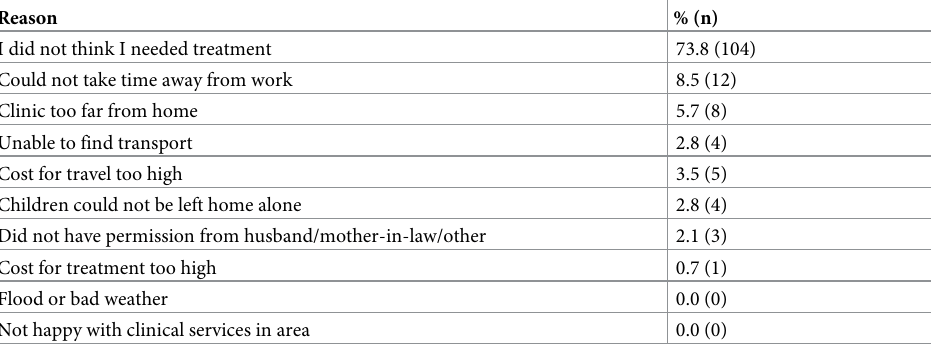
Table 4. Reasons Why RTI symptomatic women (N = 141) Did Not Seek Treatment for RTI